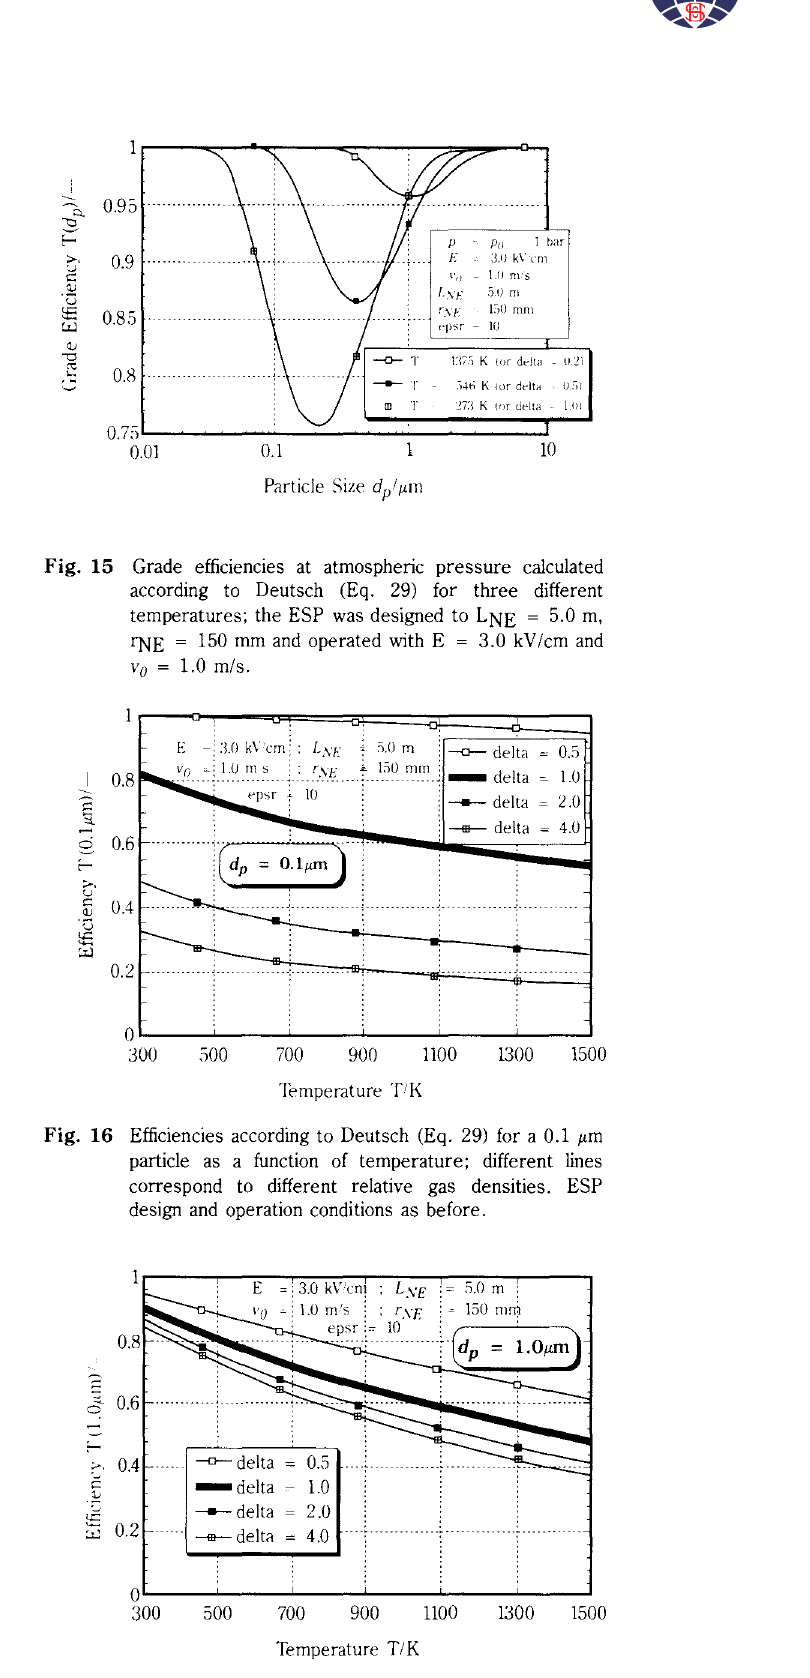
Fig. 17 Efficiencies according to Deutsch (Eq. 29) for a 1.0 JLm particle as a function of temperature; different lines correspond to different relative gas densities. ESP design and operation conditions as